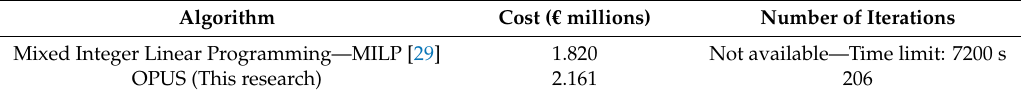
Table 8. Reported costs and number of iterations for the Pescara